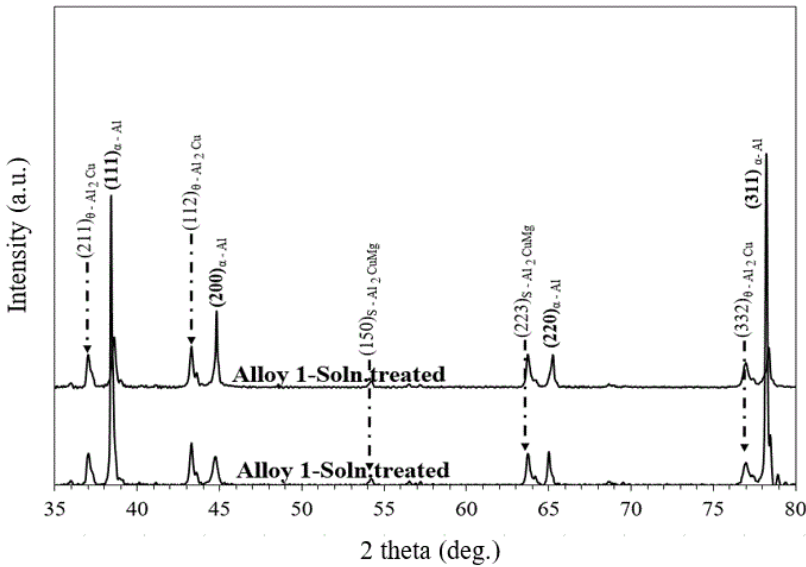
Figure 3. X-ray diffraction patterns of the solution-treated (Sol. treated) Al-Cu-Mg-Ag alloys.